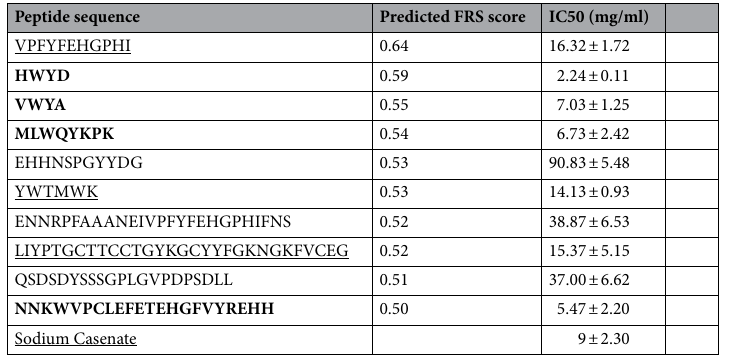
Table 2. Overview over the 10 new experimentally tested peptide sequences, ranked according to the FRS score predicted by our model (from largest to smallest) and their IC50. A low IC50 is evidence for high scavenging activity. Rows are coloured according to their experimental FRS activity (obtained as described in methods) compared to Sodium Caseinate, a known antioxidant. Peptides in bold have a higher activity than Sodium Caseinate, and underlined peptides have a similar (less than twice IC50)